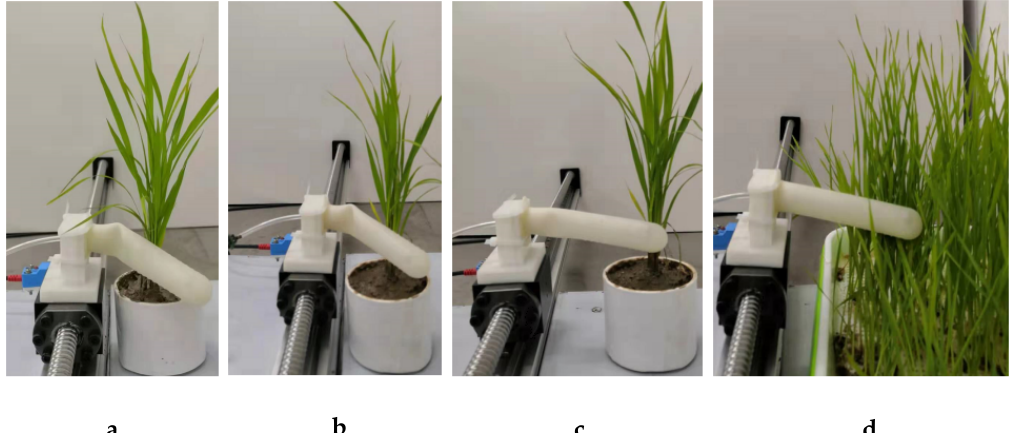
Figure 3. Contact process of gasbag with rice and weeds: ( a ) contact between the root of the gasbag and rice; ( b ) contact between the middle of the gasbag and rice; ( c ) contact between the end of the gasbag and rice; ( d ) contact between the gasbag and weeds.